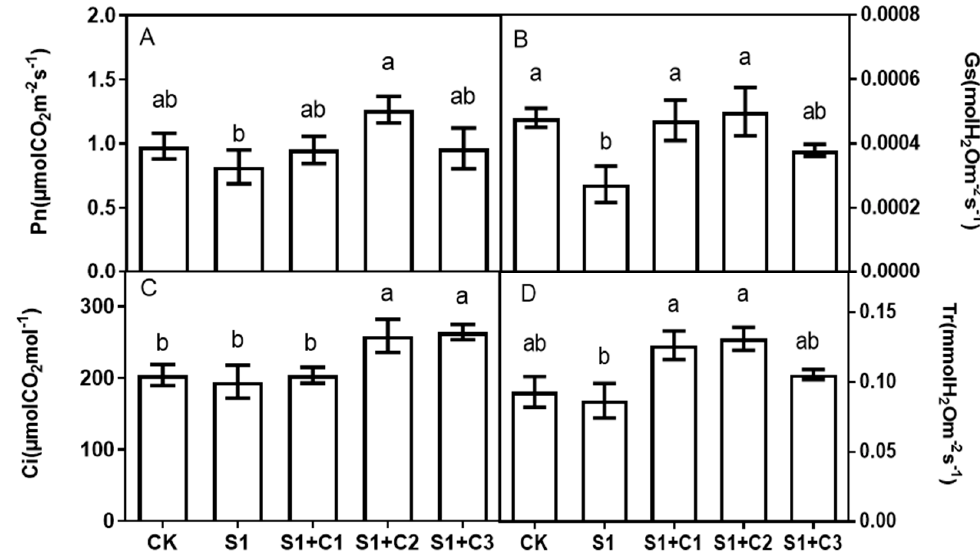
Figure 3. Effect of exogenous calcium on photosynthetic system parameters of G. sinensis . Pn, photosynthetic rate ( A ); Gs, leaf stomatal conductance ( B ); Ci, CO 2 concentration between cells ( C ); Tr, transpiration rate ( D ). The hydroponic three-week G. sinensis plants grow under normal conditions and were simultaneously treated with 100 mmol/L NaCl and CaCl 2 at concentrations of 0, 5, 10, and 15 mmol/L. After one week of treatment, the leaves at the same position were measured using a portable photosynthesis system. The data were obtained on the basis of three independent replicates. The average value was SD. The mean values represented by the different letters were significantly different in Tukey’s test at p < 0.05.